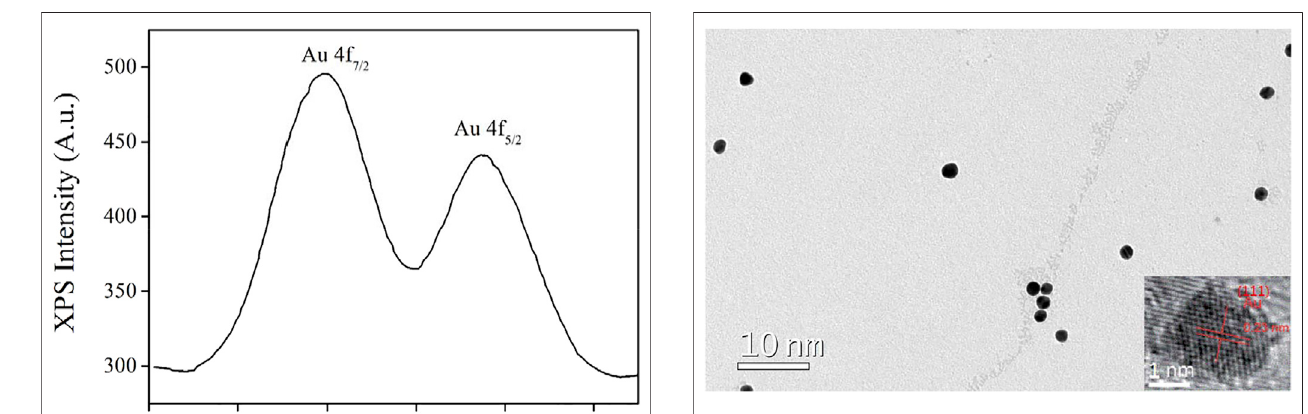
FIGURE 3 | TEM image of the